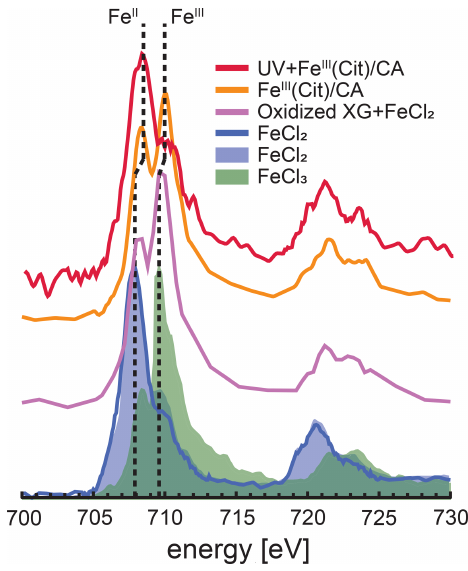
Figure 3. Iron L-edge NEXAFS spectra of Fe III ( Cit )/ CA particles before and after irradiation with UV light shown as orange and red, respectively. The previously recorded spectrum from mixed xanthan gum (XG) and FeCl 2 particles exposed to ozone is shown as the pur- ple line, and a spectrum from FeCl 2 particles is shown as the blue line (Alpert et al., 2019). FeCl 2 and FeCl 3 spectra from Moffet et al. (2012) are shown as the blue and green shading, respectively. The vertical dashed lines indicate that peak X-ray absorption at 707.9eV shifted to 708.3eV for Fe II and 709.6eV shifted to 710.0eV for Fe III